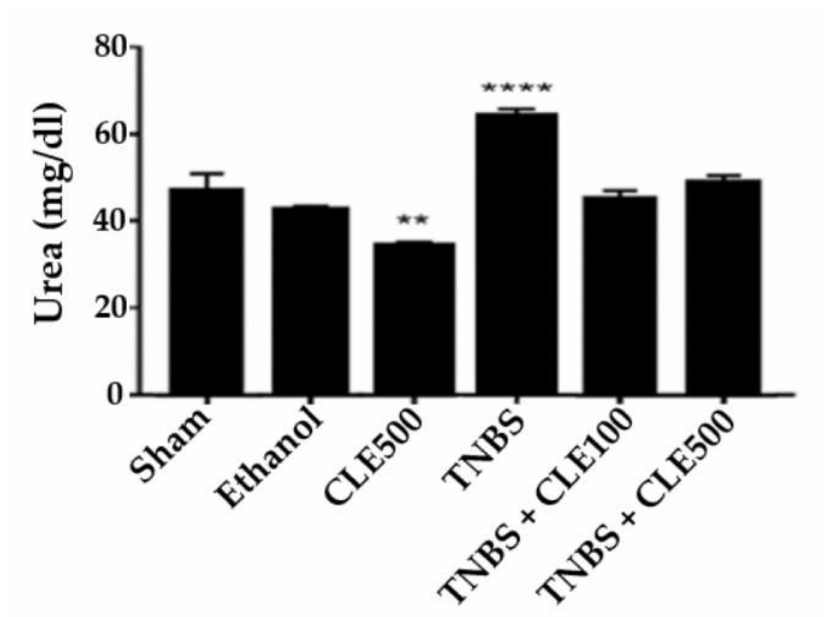
Figure 6. CLE influence on urea levels in IBD context. Legend: One-way ANOVA and Tuckey’s post hoc test; ** p < 0.01, **** p < 0.0001, in comparison to the sham group. Abbreviations: CLE, C. cardunculus L. extract; TNBS, 2,4,6-trinitrobenzene sulfonic